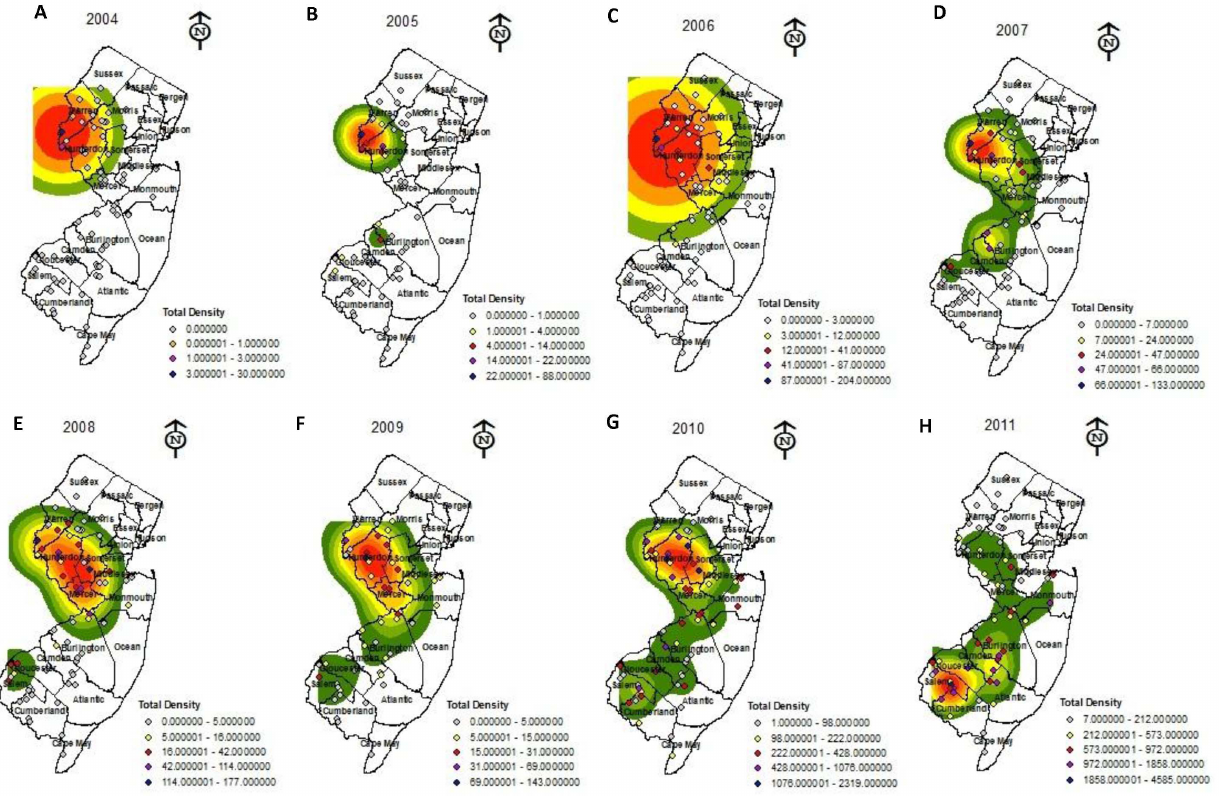
Figure 2. Kernel Density Estimation (KDE) graphs of the density of Halymorphahalys captured from black light traps placed throughout New Jersey from (A) 2004, (B) 2005, (C) 2006, (D) 2007, (E) 2008, (F) 2009, (G) 2010, (H) 2011. KDE are based on actual and predicted density of H. halys where green reflects lowest population density, orange moderate to high population density, and red predicts highest population of H. halys . Total density of H. halys’ for year black lights were monitored is also provided.